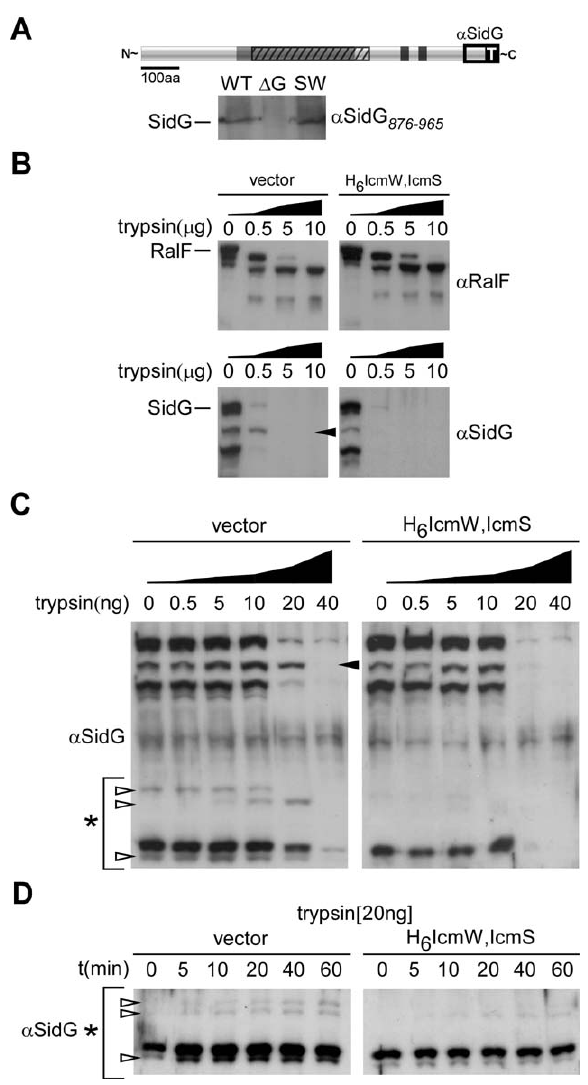
Figure 9. IcmSW Binding to SidG Promotes Conformational Changes in the Effector Protein (A) Schematic representation of the SidG polypeptide, with the IcmSW binding domain shown (hatch) as well as the indicated C-terminal domain (876–965) used for generation of polyclonal antisera. Full-length SidG was detected at equivalent levels from wild-type (WT) or D icmS , D icmW mutant L. pneumophila (SW) and was not detected in the sidG deletion strain ( D G). (B) Recombinant RalF or SidG were co-expressed in the absence (vector) or presence of the IcmSW complex (H 6 IcmW,IcmS), and subjected to lysis and clarification. Aliquots of soluble whole-cell lysates were subjected to the indicated concentrations of trypsin for 1 h. Samples were subjected to SDS-PAGE and immunoblotting, where proteolytic fragments of RalF (RalF (cid:2) ) or SidG (SidG (cid:2) ) were detected with specific antisera raised against the indicated polypeptides. The black arrow indicates predom- inant cleavage product. (C) Lysates containing SidG were processed as in (B), except that trypsin was diluted 1,000-fold. Proteolytic cleavage fragments (white arrows) emerge in the absence of IcmSW in the molecular size range of 50–60 kDa as indicated by the asterisk. (D) Proteolytic time course experiment performed at indicated concen- tration (20 ng) on SidG-containing lysates. Immunoblots show differ- ential cleavage products (arrows) in the 50–60 kDa molecular size range